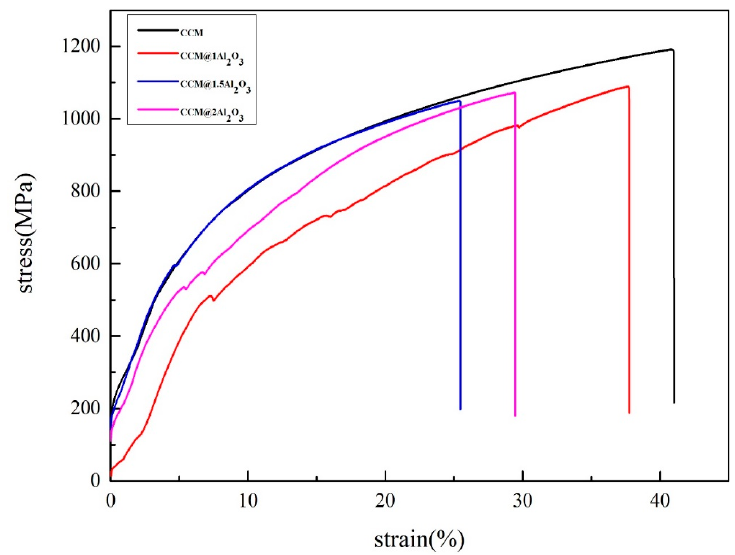
Figure 13. Stress-strain curves of the LPBF-processed parts. Table 4. Tensile properties of the LPBF-processed parts.